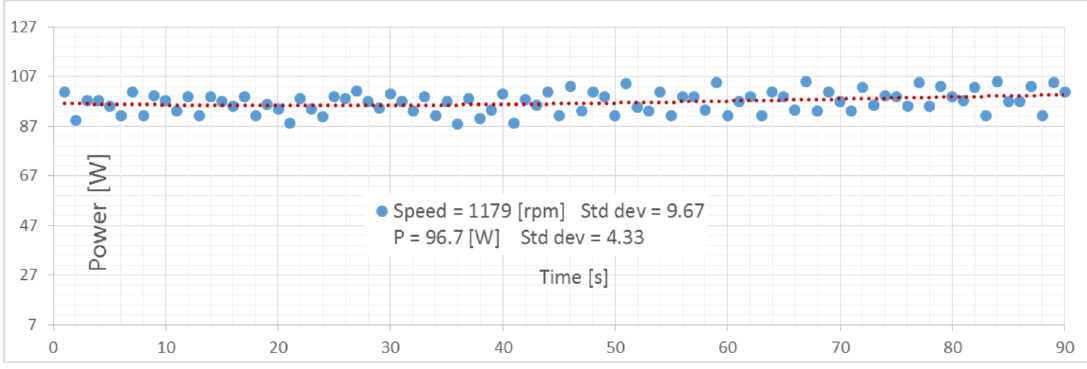
Figure 21. Results of bollard pull thrust tests: power vs. thrust.